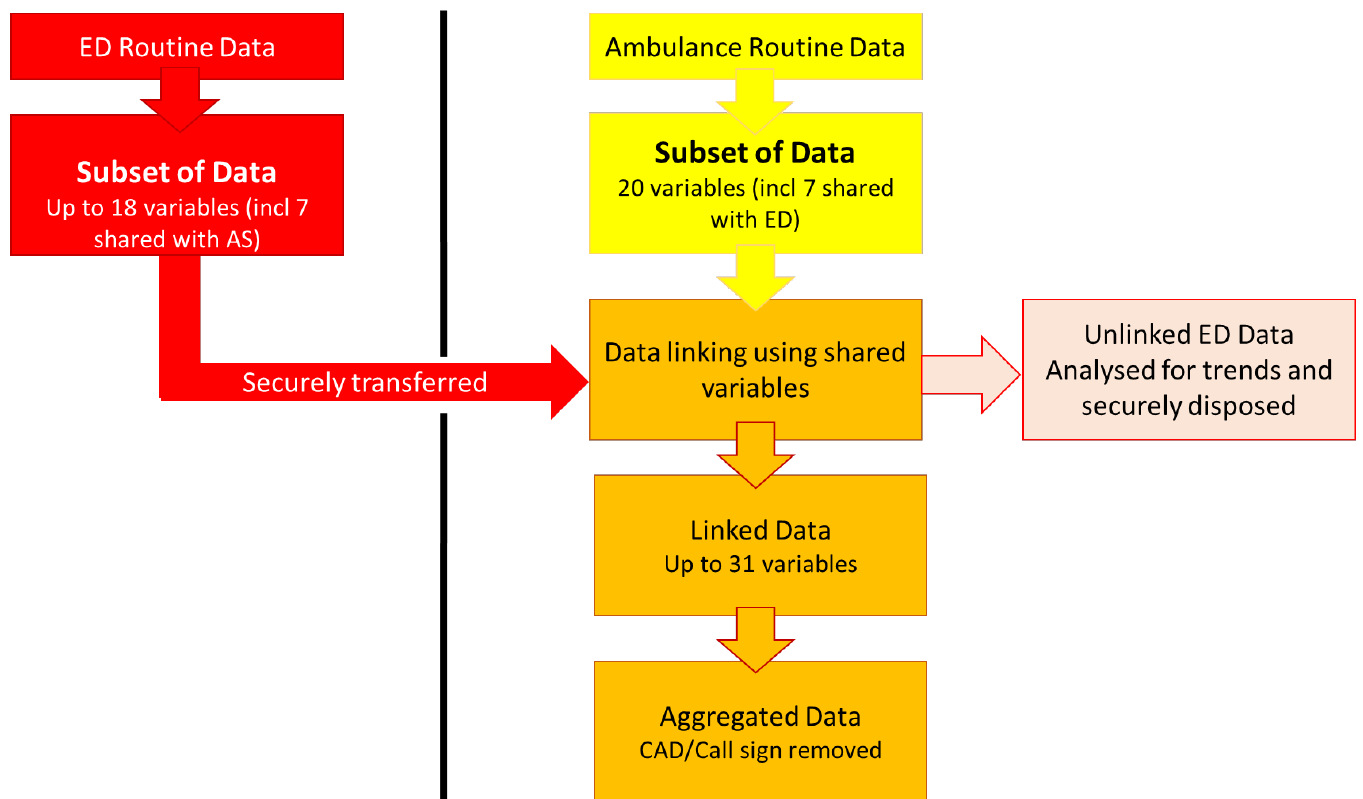
Figure 2: The process of data collection and linkage.